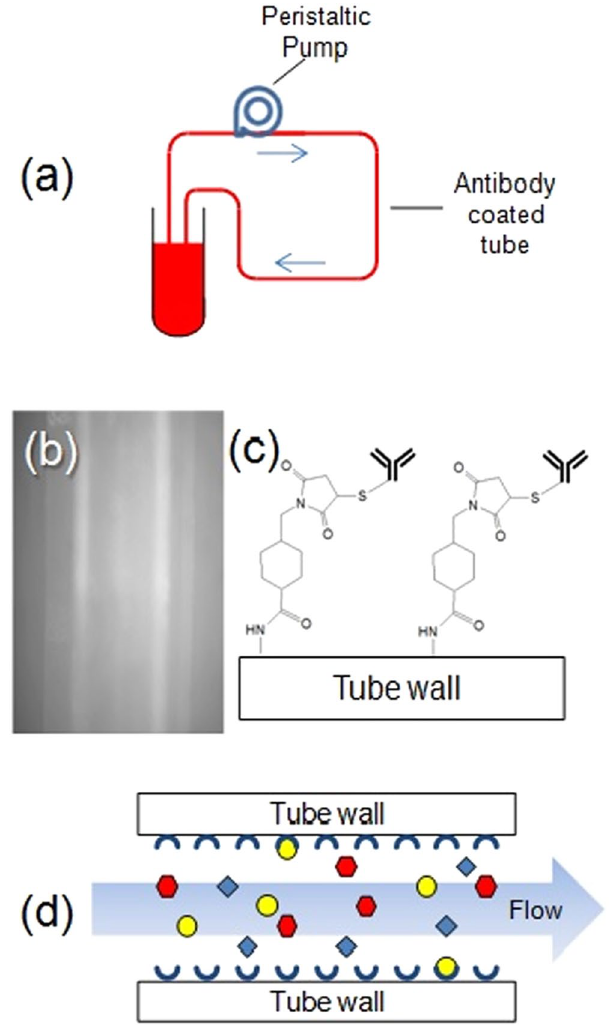
Figure 1. Principle of tube capturing by constant flow ( a ) Diagram of experimental setup. ( b ) Fluorescence image S . aureus antibody coated tube, confirmed by staining with Alexa 488 labeled secondary antibody. ( c ) Diagram of antibody coated tube surface showing the tube chemistry. ( d ) Selective pathogen capturing inside